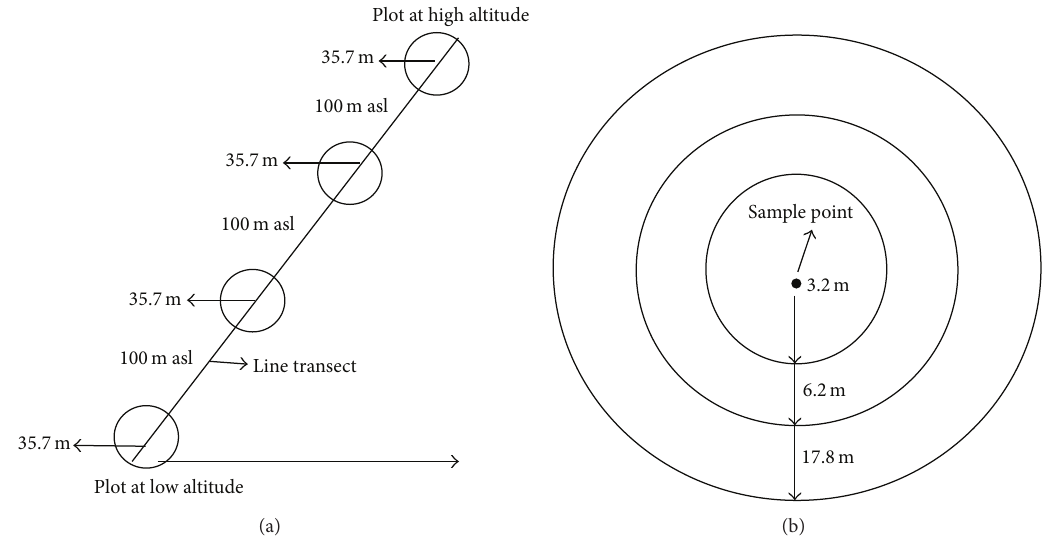
Figure 2: Line-transect and plot design. (a) represents line-transect including the plots starting from low altitude to higher altitude. (b) represents each single plot and sub-plots within it. This figure is a modified form of the line-transect method [24]. asl shows above the sea level.